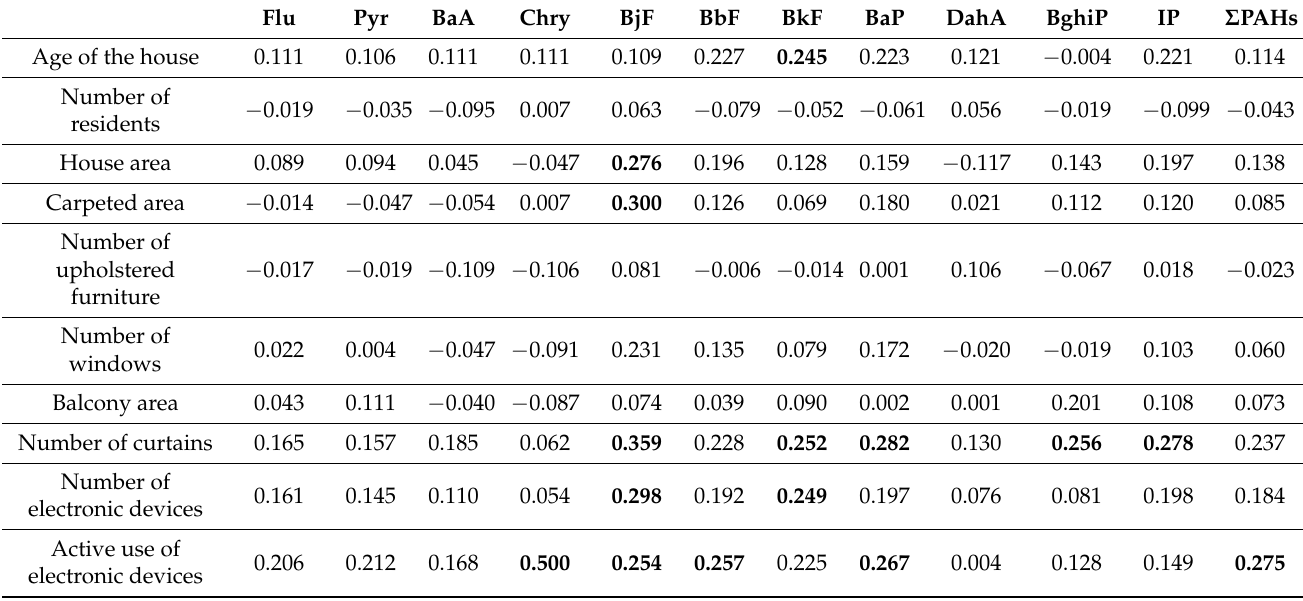
Table 4. Spearman correlation coefficients (r) between PAH mass fractions measured in house dust samples from the city of Zagreb and data collected on corresponding household factors (significant correlations ( p < 0.05) are shown in